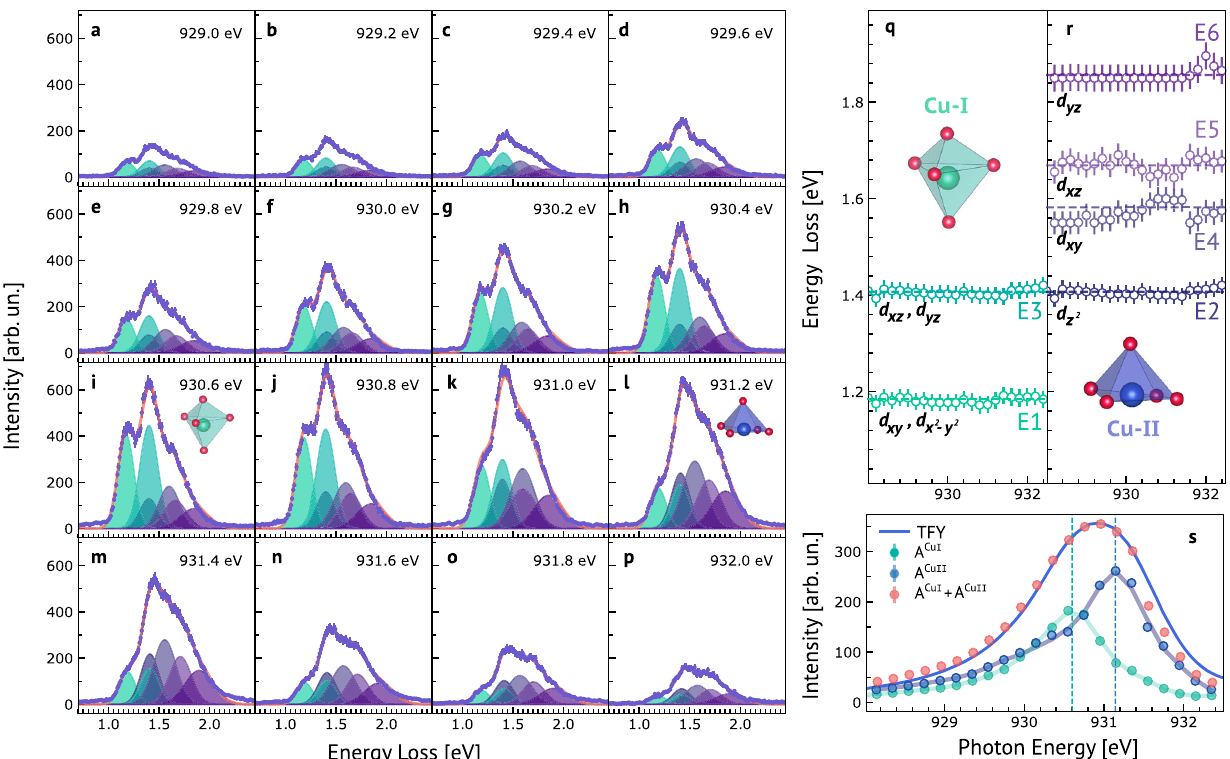
Fig. 3 Analysis of dd -excitations in Cu 2 OSeO 3 . a – p Resonant inelastic X-ray scattering (RIXS) spectra (dots), in the 0.8 – 2.5 eV region, as a function of incident energy across the Cu L 3 edge. The error bars are de fi ned assuming a Poisson distribution of the single-photon counted events. The fi tted components are colored in aquamarine for the Cu-I dd -excitations (E1 and E3), and in purple for the Cu-II dd -excitations (E2, E4, E5, and E6). The sum of the fi tted components is represented as a pink, thick solid line. q , r Summary of the fi tted dd -excitation energies across the Cu L 3 edge, with the assigned orbital character following density functional theory (DFT) calculations. s Site-resolved dd -excitation amplitudes A CuI (aquamarine dots) and A CuII (blue dots). The error bars, extracted from the fi tting through the error propagation method, are contained within the marker size. The smoothed lines underneath are a guide for the eyes. The sum of the A CuI and A CuII amplitudes is displayed by the pink dots. A rescaled total fl uorescence yield (TFY) pro fi le is plotted in the same fi gure using a blue solid line. Vertical dotted lines mark the resonant energy extracted for Cu-I ion at 930.6 eV and Cu-II ion at 931.15 eV.